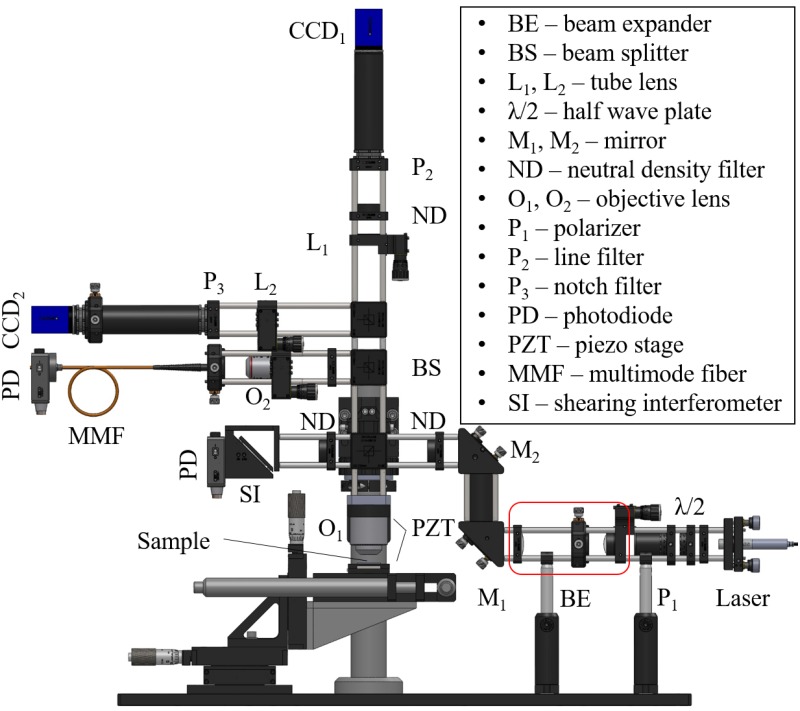
Experimental Setup.